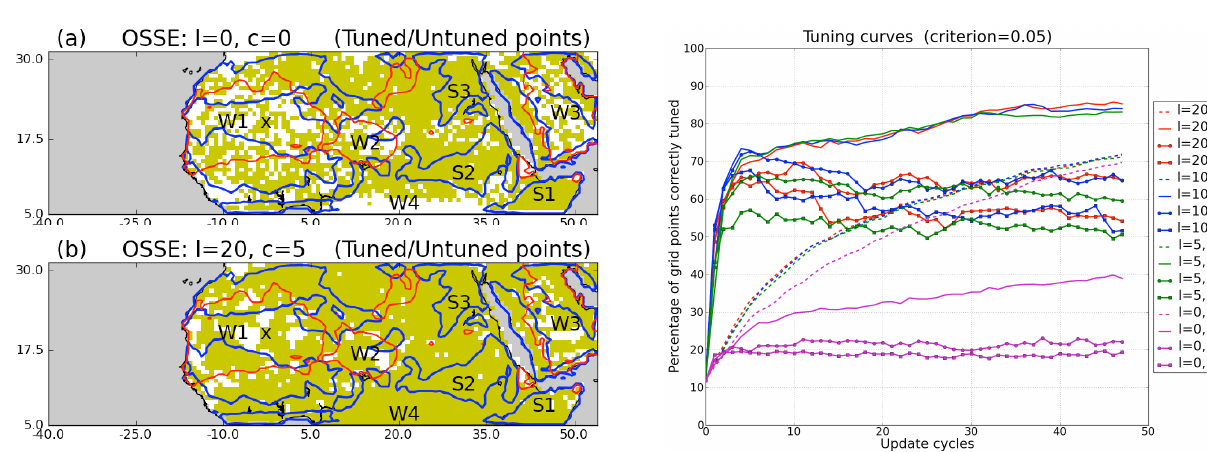
Fig. 5. The tuning curves for OSSE experiments with different val- ues of l and c . Each curve shows the percentage of grid points tuned correctly as the update cycles proceed. The values of l and c are Figure 5 : The tuning curves for OSSE experiments with different values of l specified in grid point units. A distance of 10 grid points corre- and c. Each curve shows the percentage of grid points tuned correctly as sponds to 800km. For this problem a correlation length scale of the update cycles proceed. The values of l and c are specified in grid point 5 grid points (400km) gives the best results. See Sects. 4 and 5 for units. A distance of 10 grid points corresponds to 800 km. For this problem a correlation length scale of 5 grid points (400 km) gives the best results. See sections 4 and 5 for discussion.